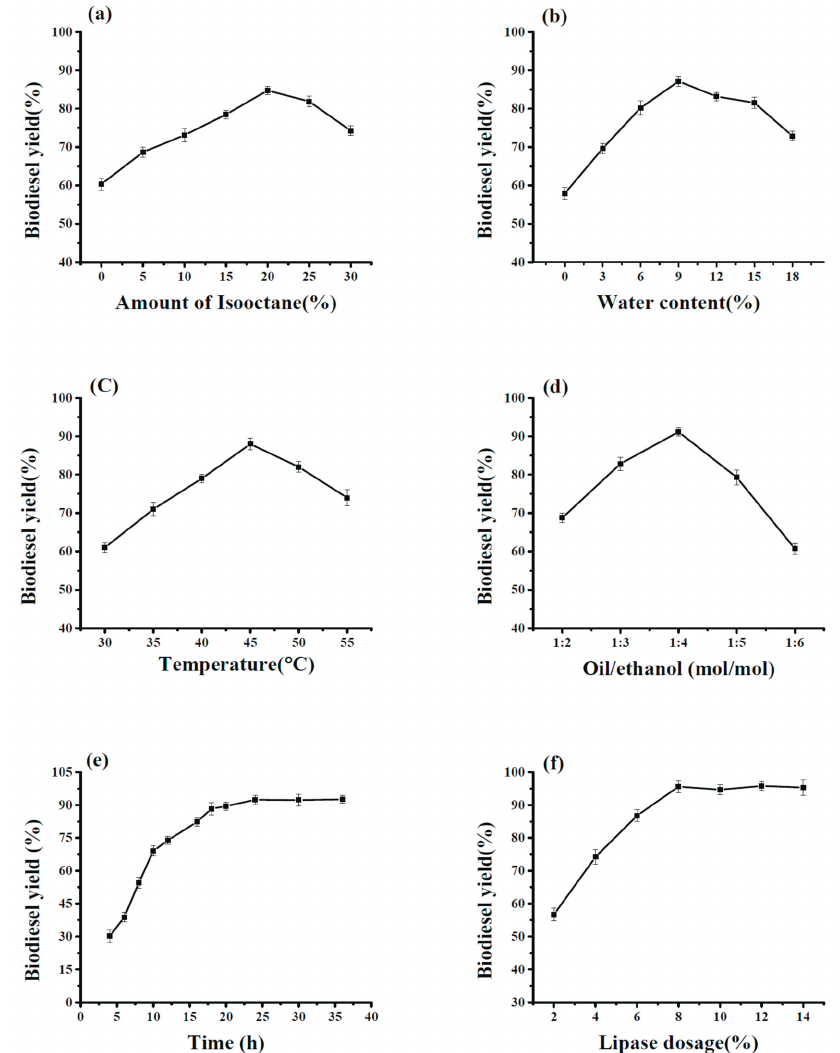
Figure 7. Impacts of reaction parameters on biodiesel production catalyzed by RML@ZIF-8. ( a ) The amount of isooctane. ( b ) Water content. ( c ) Reaction temperature. ( d ) Molar ratio oil to ethanol. ( e ) Reaction time. ( f ) The dosage of lipase.